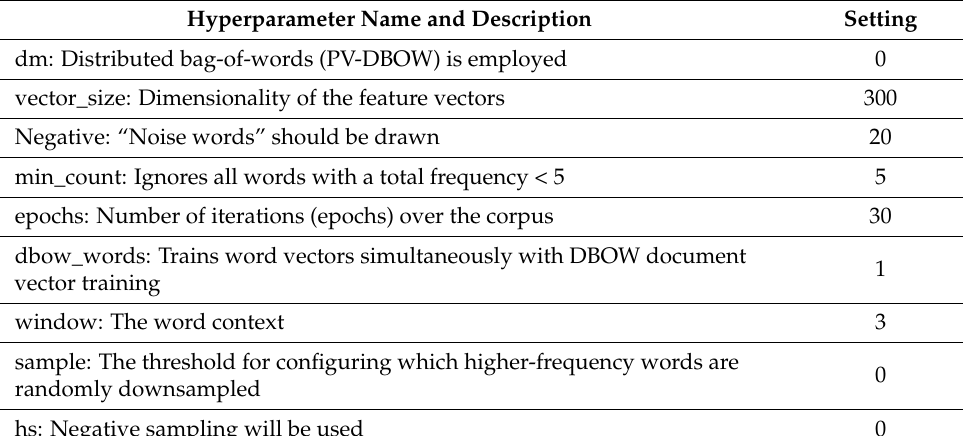
Table 2. Hyperparameter Values. Hyperparameter Name and Description